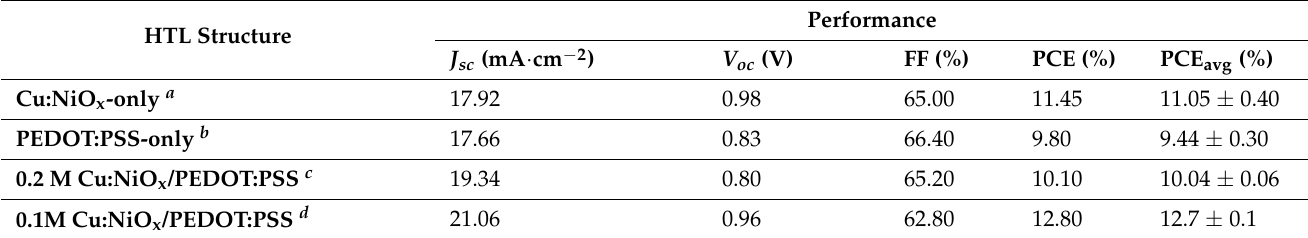
Table 1. Current-voltage characteristics and performance efficiencies obtained for the different HTL structures. (R s and R sh denote series and shunt resistance, respectively). HTL